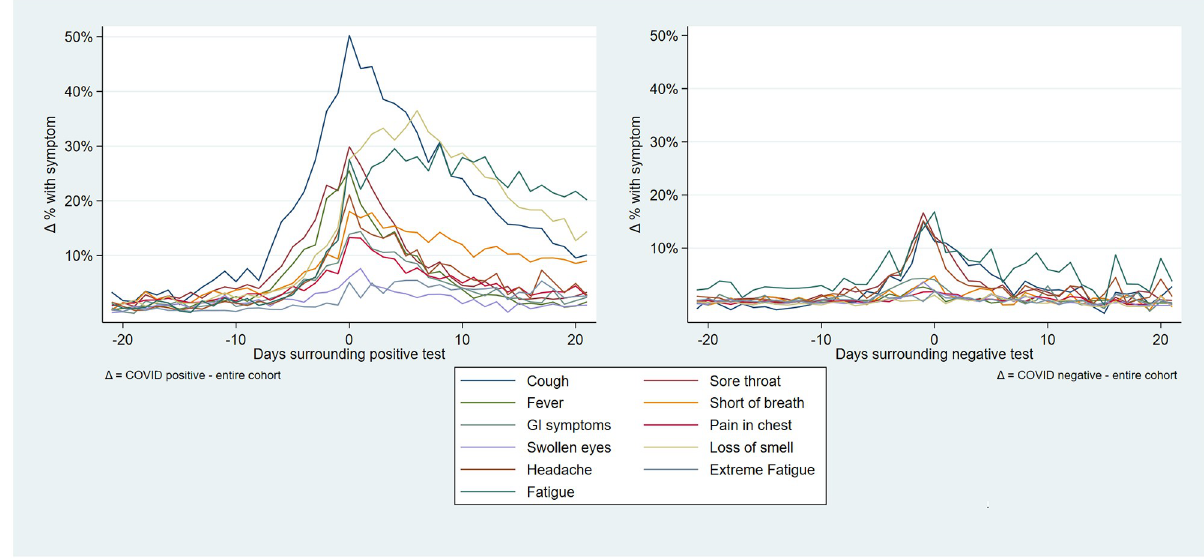
Fig 5. a) Daily reported proportion of users reporting symptoms surrounding positive SARS-CoV-2 test. b) Daily reported proportion of users reporting symptoms surrounding negative SARS-CoV-2 test. Data with 95% confidence intervals in online supplement.